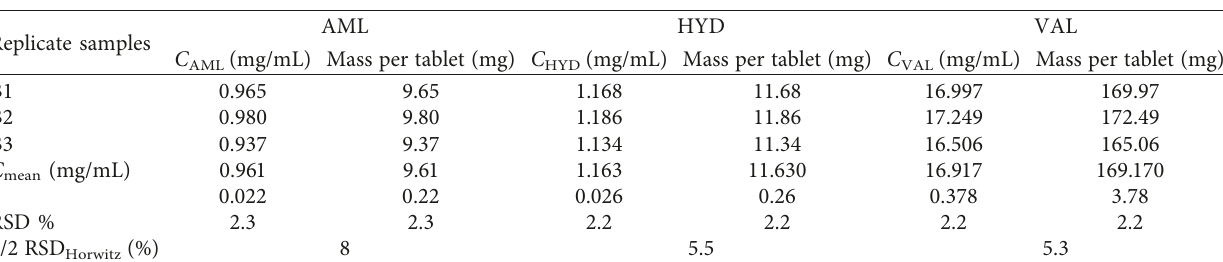
Table 7: Measured concentrations of AML, HYD, and VAL in Exforge HCT tablets employing the developed Kalman-Excel program. AML Replicate samples